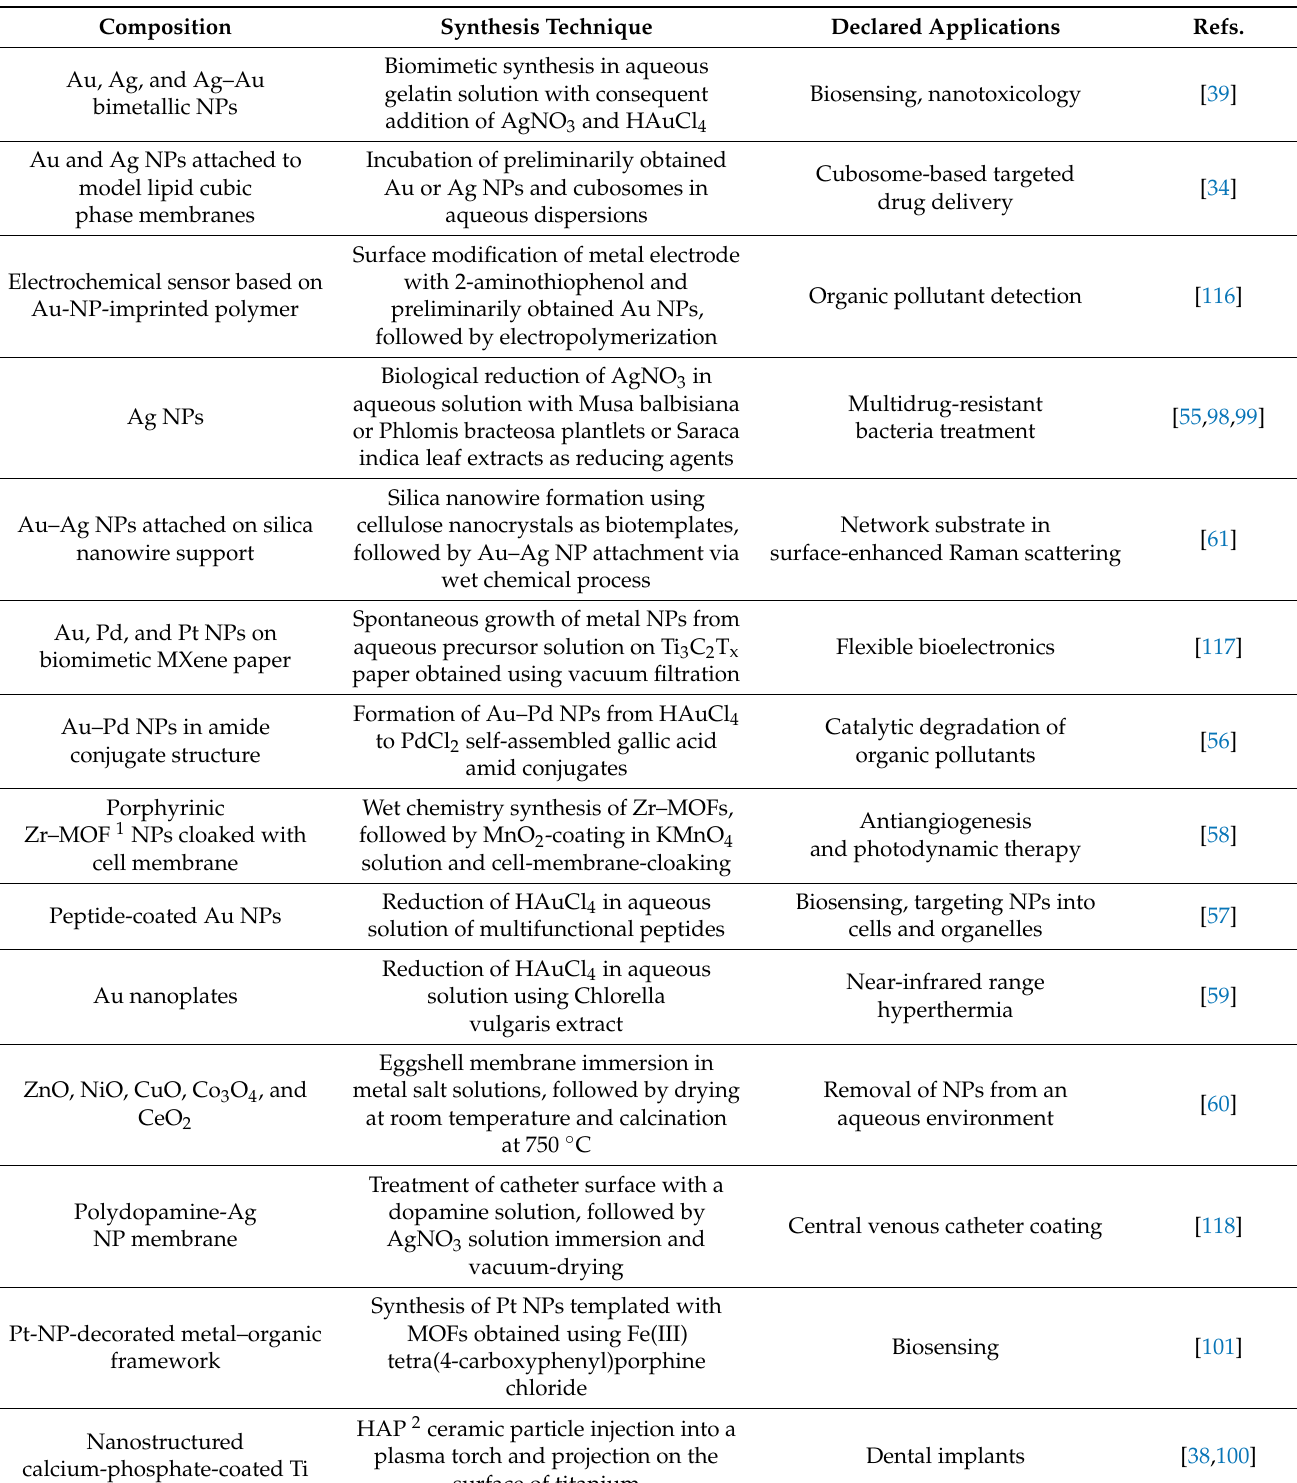
Table 2. Biomimetic nanomaterials based on particles of metals and metal oxides and areas of their